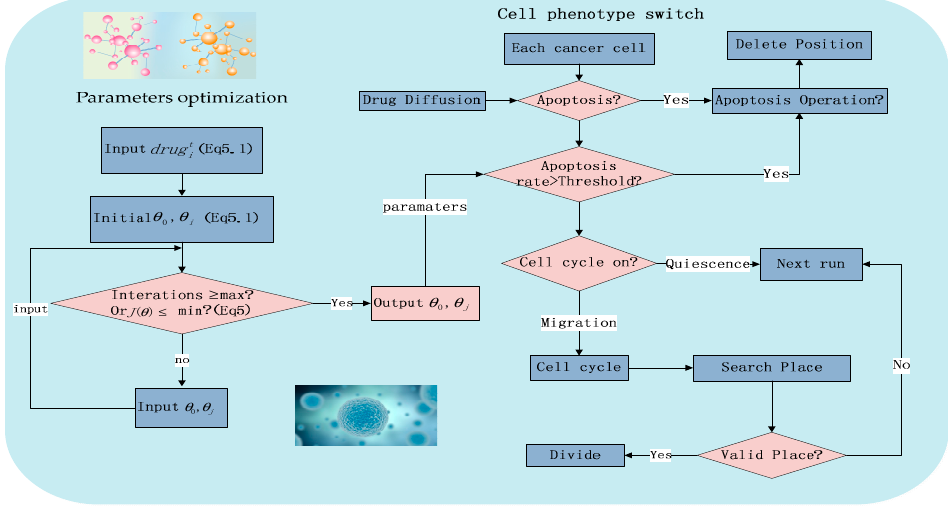
Figure 2. The flowchart of the system including phenotype switching and local parameter optimization.